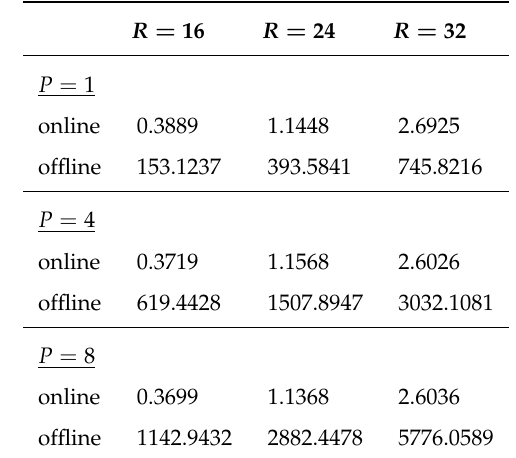
Table 4. CPU time (in seconds) for ROM prediction and predetermined model coefficients computations, denoted as online and offline stages, respectively. We note that the CPU time assessments documented in this table are based on Fortran